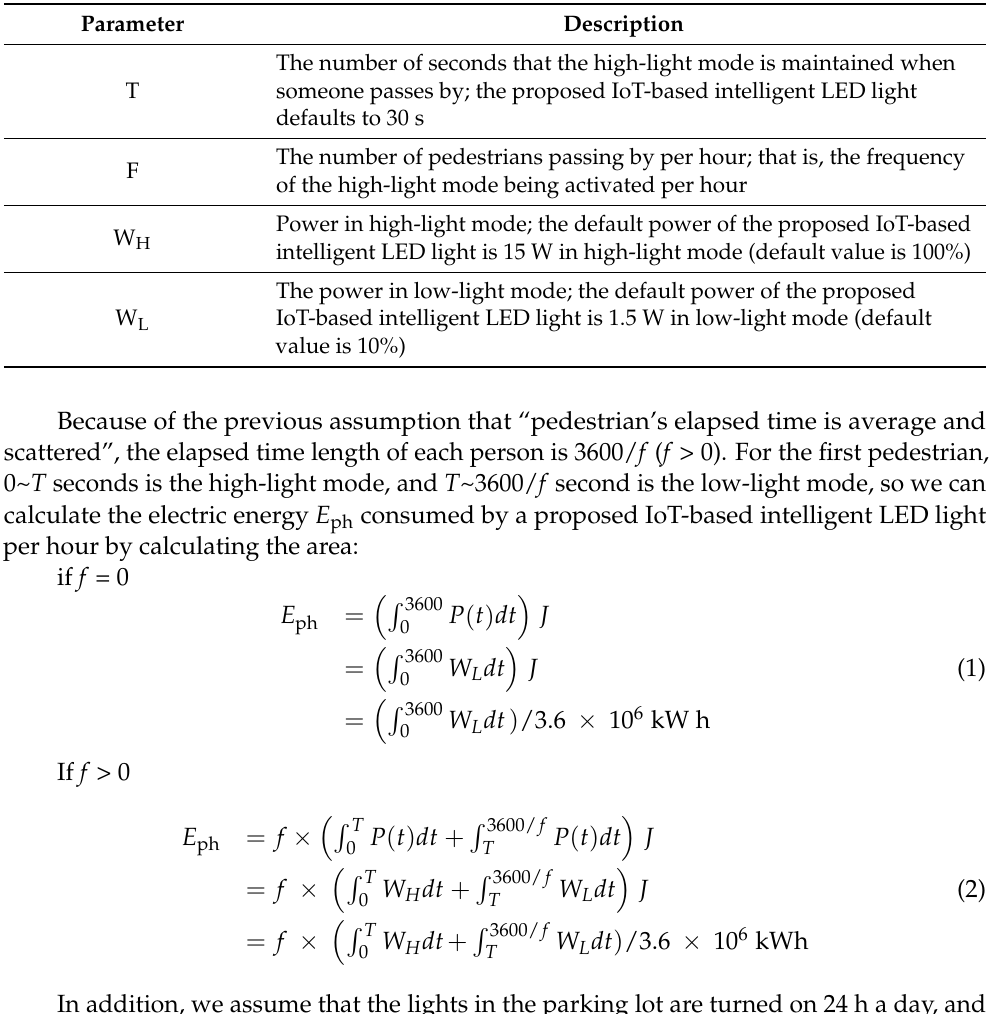
Table 6. Parameter